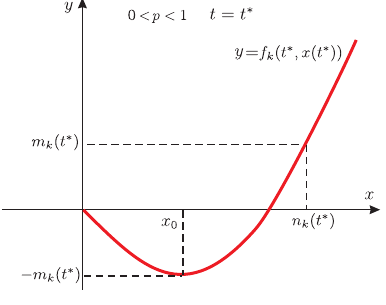
Figure 1. Existence of a number n k